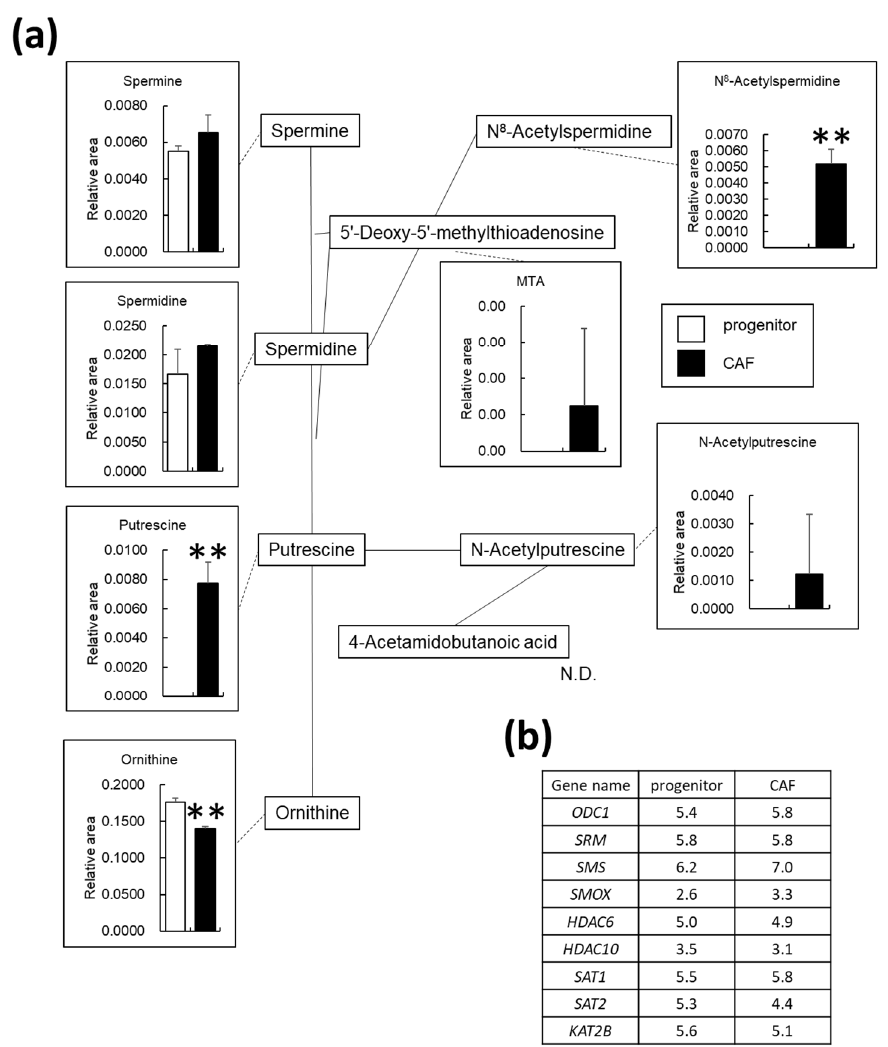
Figure 5. Changes in metabolites related to polyamine metabolism in cancer-associated fibroblasts (CAF) progenitors and CAFs: ( a ) Graphical representation of relative metabolite changes between CAF progenitors and CAFs, as determined by capillary electrophoresis time-of-flight mass spectrom- etry. N.D. indicates not detected. ** p < 0.01; ( b ) List of genes involved in polyamine metabolism and their expression levels. Log2 normalized counts per million values. There were no differentially expressed